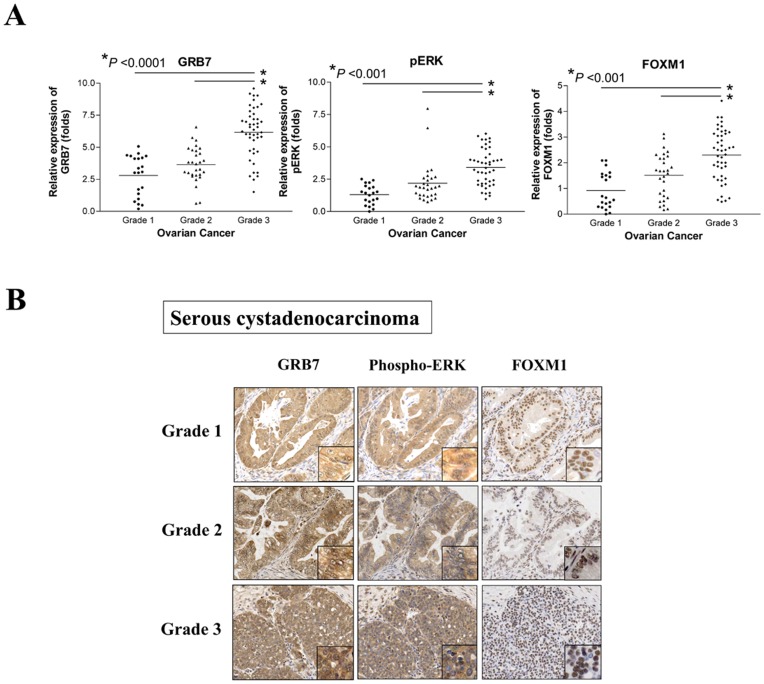
A significant stepwise increase in the expressions of GRB7, ERK phosphorylation and FOXM1 along ovarian tumor grade.(A) The expressions of GRB7, ERK phosphorylation and FOXM1 were evaluated by immunohistochemical analysis using specific antibodies on an ovarian cancer tissue array (OVC1021, Pantomics). (B) Representative pictures show the stepwise increase of GRB7, ERK phosphorylation and FOXM1 expressions from Grade 1 to Grade 3 ovarian cancer (serous subtype) (200× magnifications).